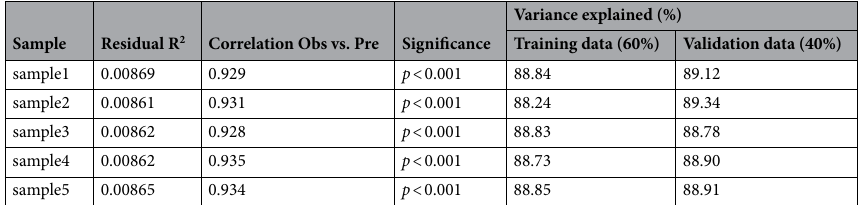
Table 8. Results of RF model and correlation between observed and predicted values.